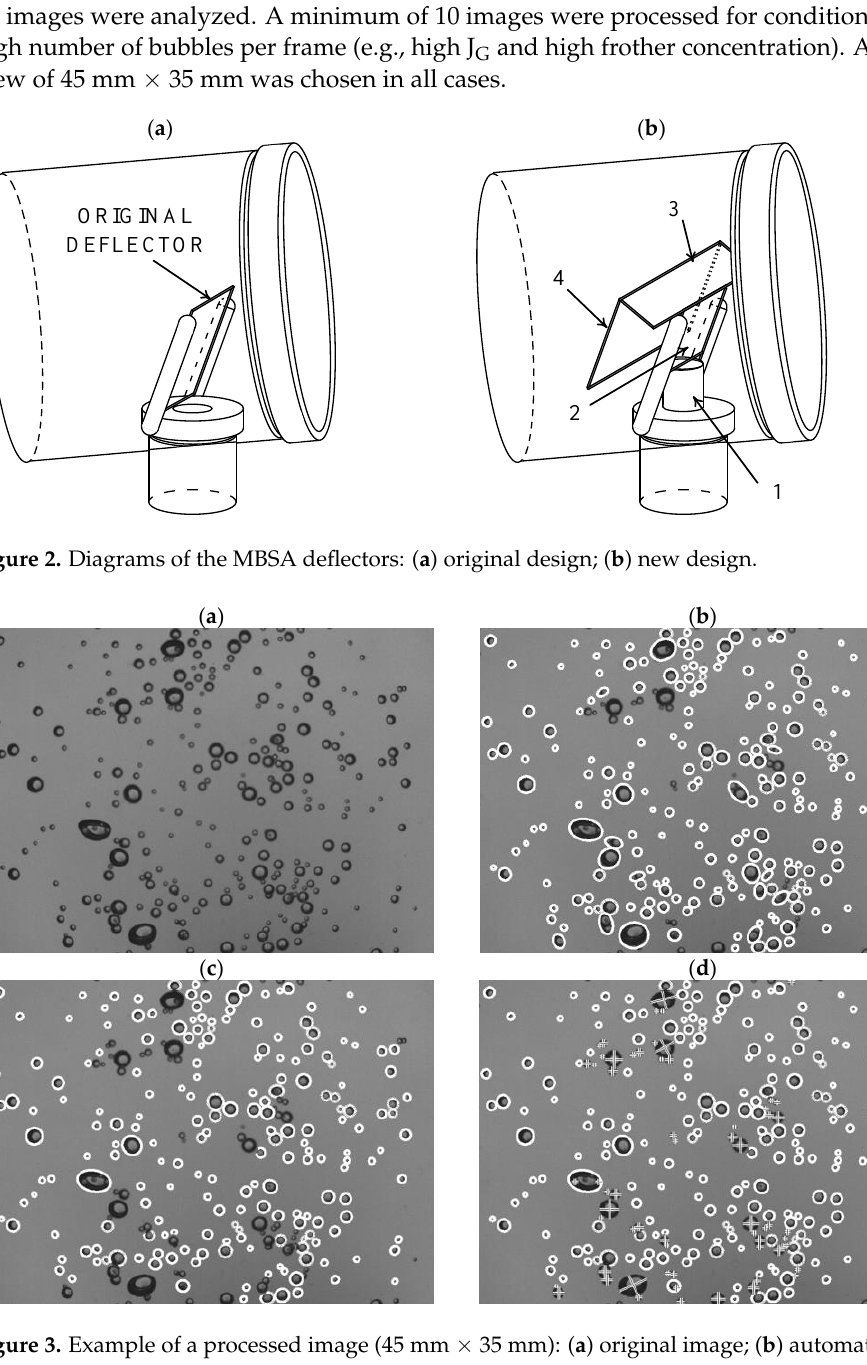
Table 1. Parameters of each image processing technique. Figure 3. Example of a processed image (45 mm × 35 mm): ( a ) original image; ( b ) automatic image processing; ( c ) false-positive removal; ( d ) manual processing.